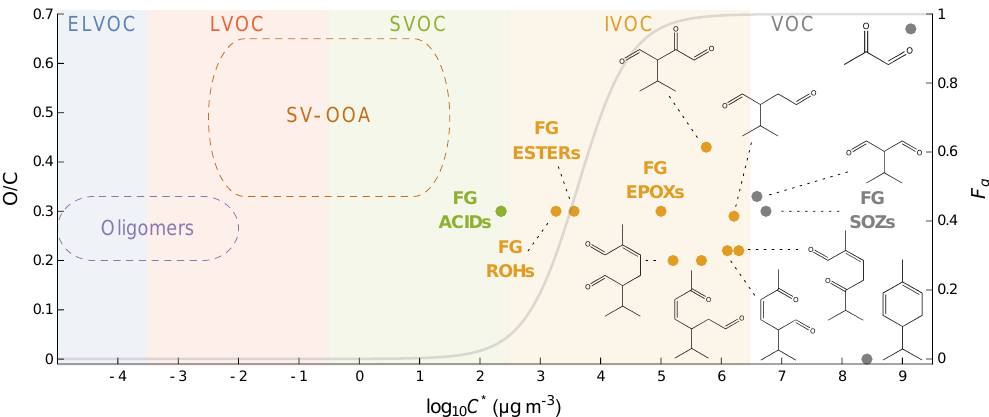
Figure 9. Dots show predicted first-generation and detected second-generation products from the ozonolysis of α -phellandrene in Donahue et al. (2006) space. The grey line shows the fraction of species of different saturation vapour concentrations in the gas phase ( F g ) after gas–wall and gas–particle equilibrium is reached, using C w = 5mgm − 3 and an SOA loading of 200µgm − 3 . Formulation of F g is given in the Supplement (Sect.